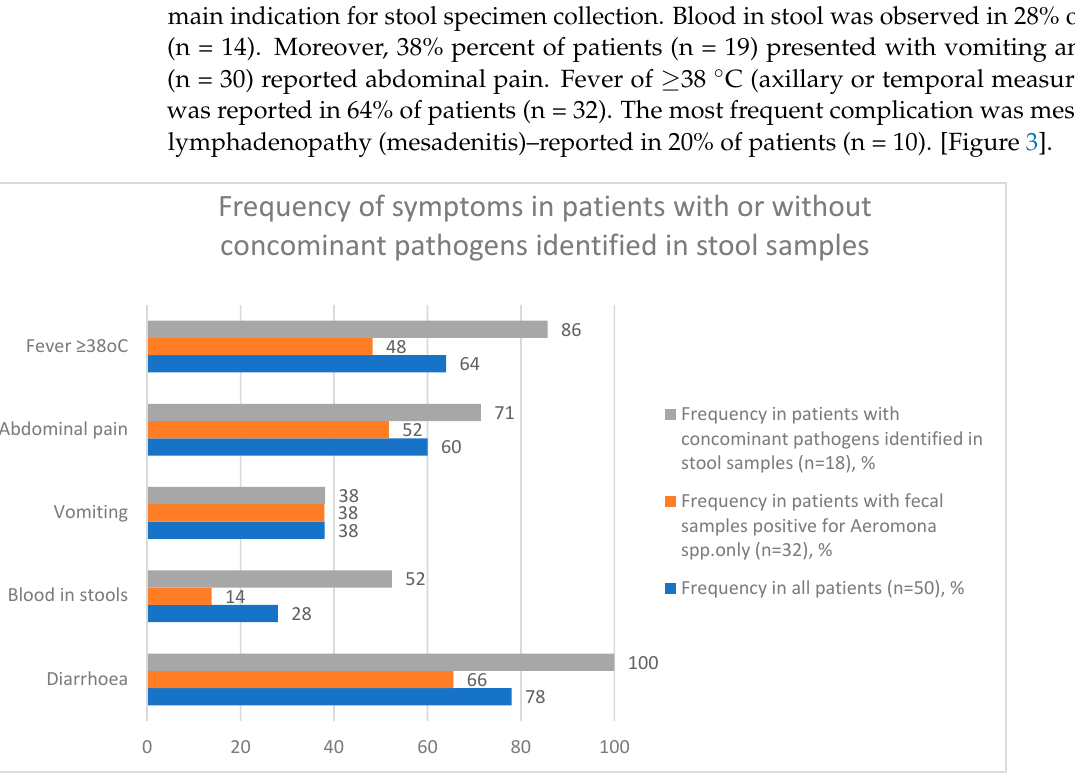
Figure 3. Frequency of symptoms in patients with or without concomitant pathogens identified in stool samples.